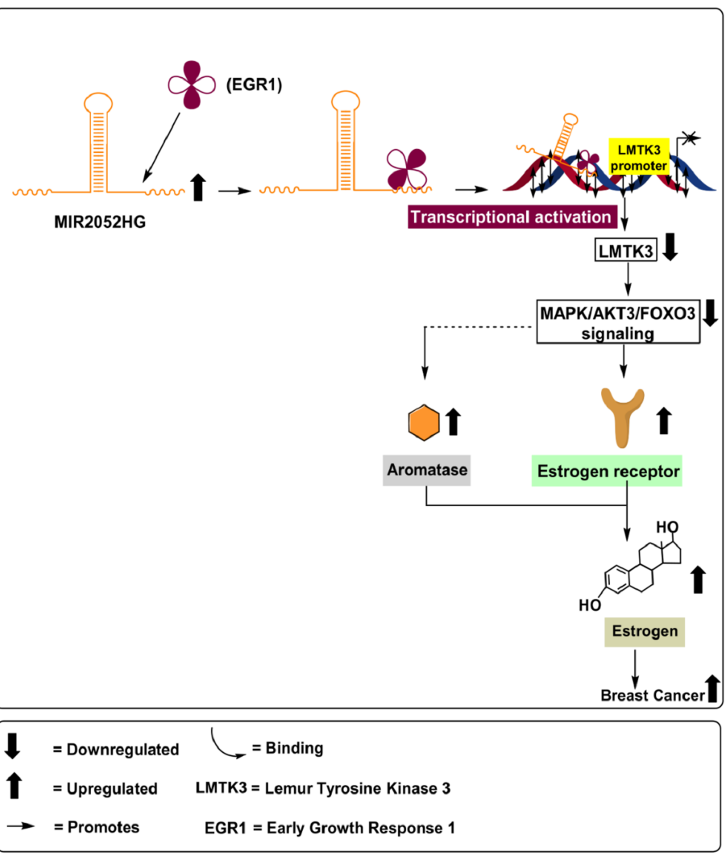
Figure 5. Role of lncRNA MIR2052HG in upregulating aromatase levels via activation of MAPK/Akt3/FOXo3 signalling pathways, leading to increased ER α and ESR1 stability in breast cancer patients.